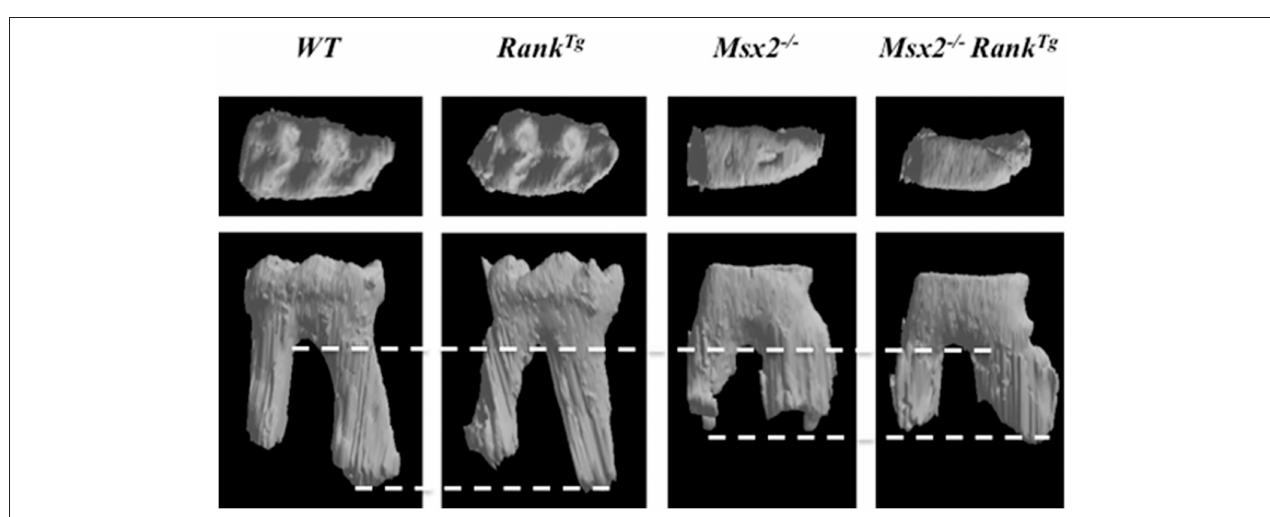
FIGURE 4 | Roots and crown morphologies of the mandible first molars of adult wild-type, RANK Tg , Msx2 − / − ,and Msx2 − / − RANK Tg mice. Roots of RANK Tg mouse molars are thinner and roots of Msx2 − / − mouse molars are shorter as evidenced by dash lines. Crown of Msx2 − / − − / − mouse are flat with no cuspide independently of RANK